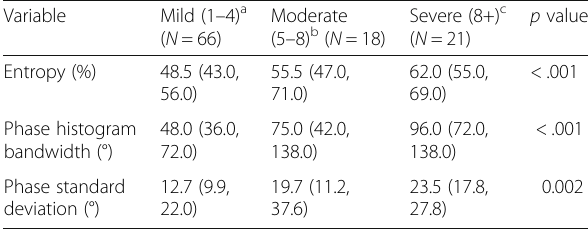
Table 3 Derivation cohort — perfusion defect severity and dyssynchrony